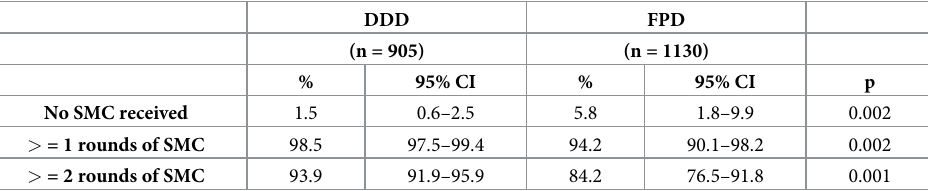
Table 3. Proportions of children who did not receive any round of SMC, who received at least one round, and who received at least two rounds, according to the method of delivery (door to door versus fixed point).